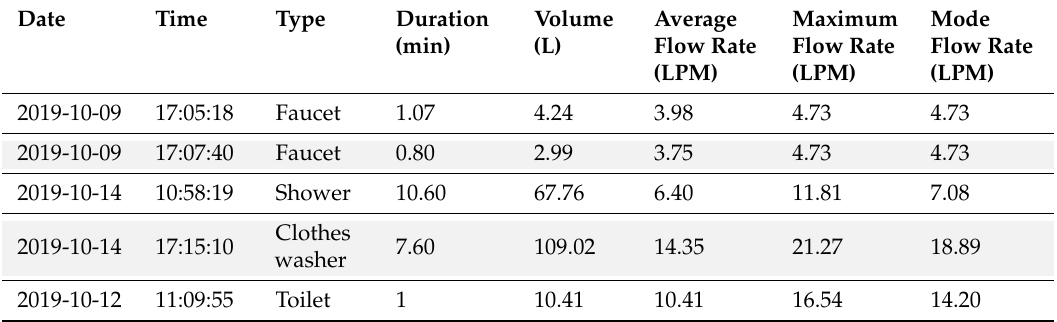
Table 9. Events logged by the homeowner at Site 1 and main characteristics calculated from the high temporal resolution data